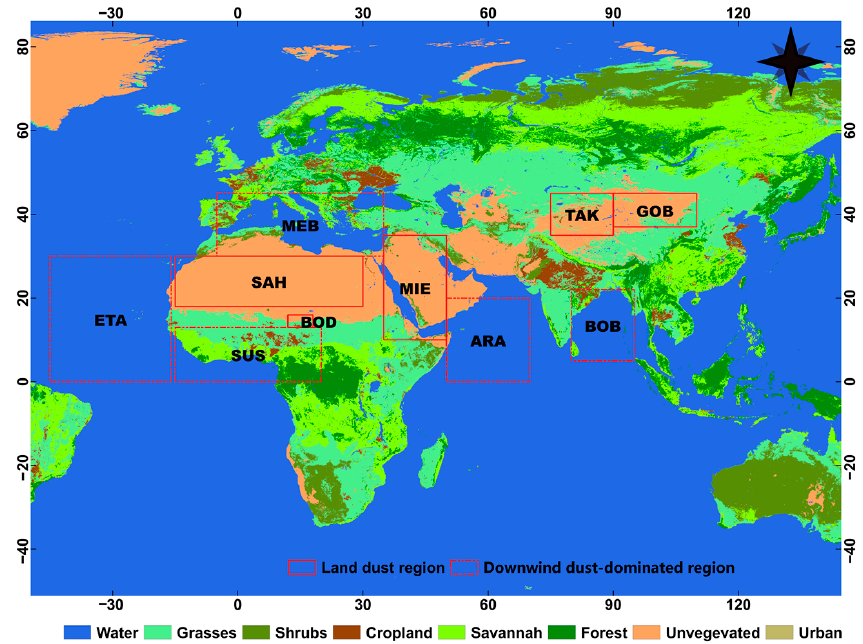
Figure 1. Regions of interest for the comparisons of monthly dust column concentration: Sahara Desert (SAH), Bod é l é Depression (BOD), Middle East (MIE), Taklamakan Desert (TAK), Gobi Desert (GOB), Eastern Tropical Atlantic (ETA), Sub-Sahel (SUS), Mediterranean Basin (MED), Arabian Sea (ARA), Bay of Bengal (BOB). Solid rectangles indicate the dust emission resource regions and dashed rectangles indicate the important downwind dust-dominated